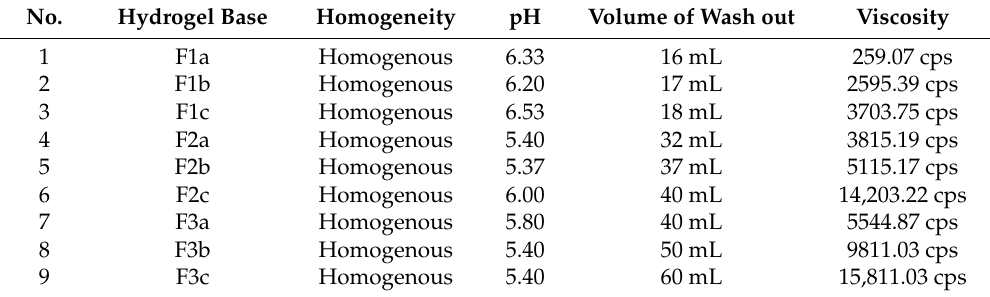
Table 2. Result of hydrogel base